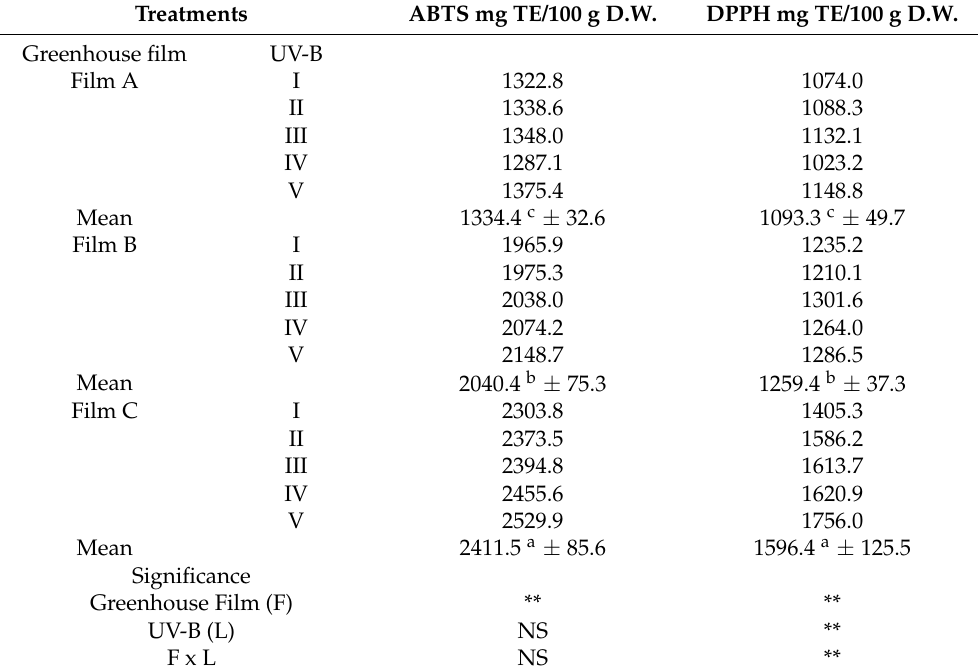
Table 2. Antioxidant activity (mg TE/100 g D.W.) in wild rocket leaves as affected by the main effect of greenhouse cover film (Film A: diffused light film; Film B: clear film; Film C: diffused light film with UV-B window) and the interaction between films and UV-B application (I: not treated with UV-B; II: treated with UV-B for 45 s; III: treated with UV-B for 150 s; IV: treated with UV-B for 330 s; V: treated with UV-B for 660 s). Treatments ABTS mg TE/100 g D.W. DPPH mg TE/100 g D.W. Greenhouse film